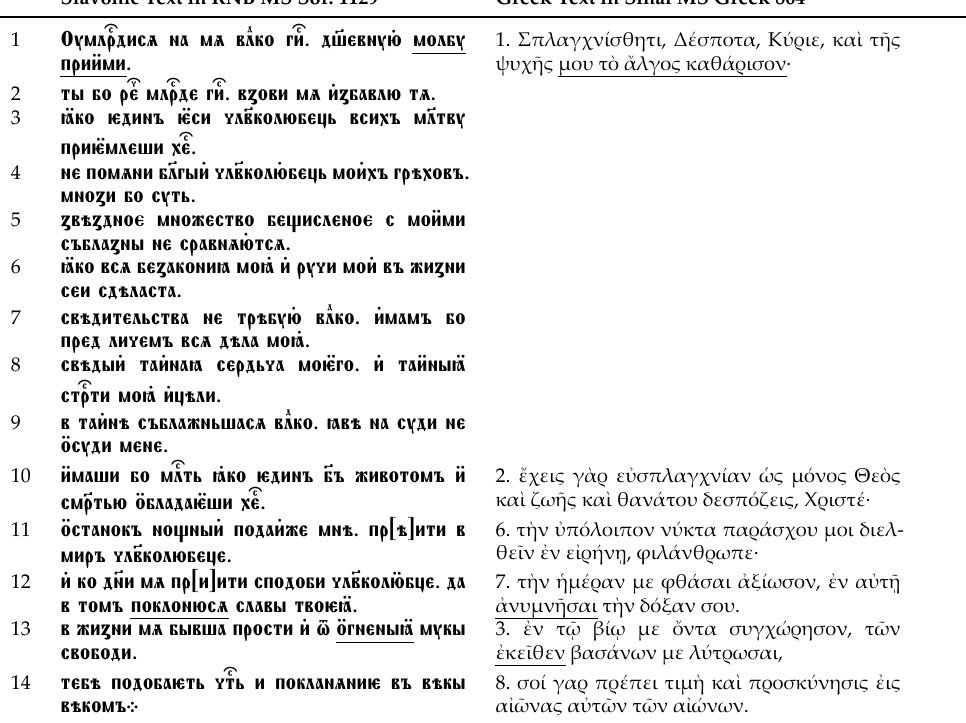
Table 6. The Slavonic and Greek texts of hymn No. 34. Slavonic Text in RNB MS Sof.